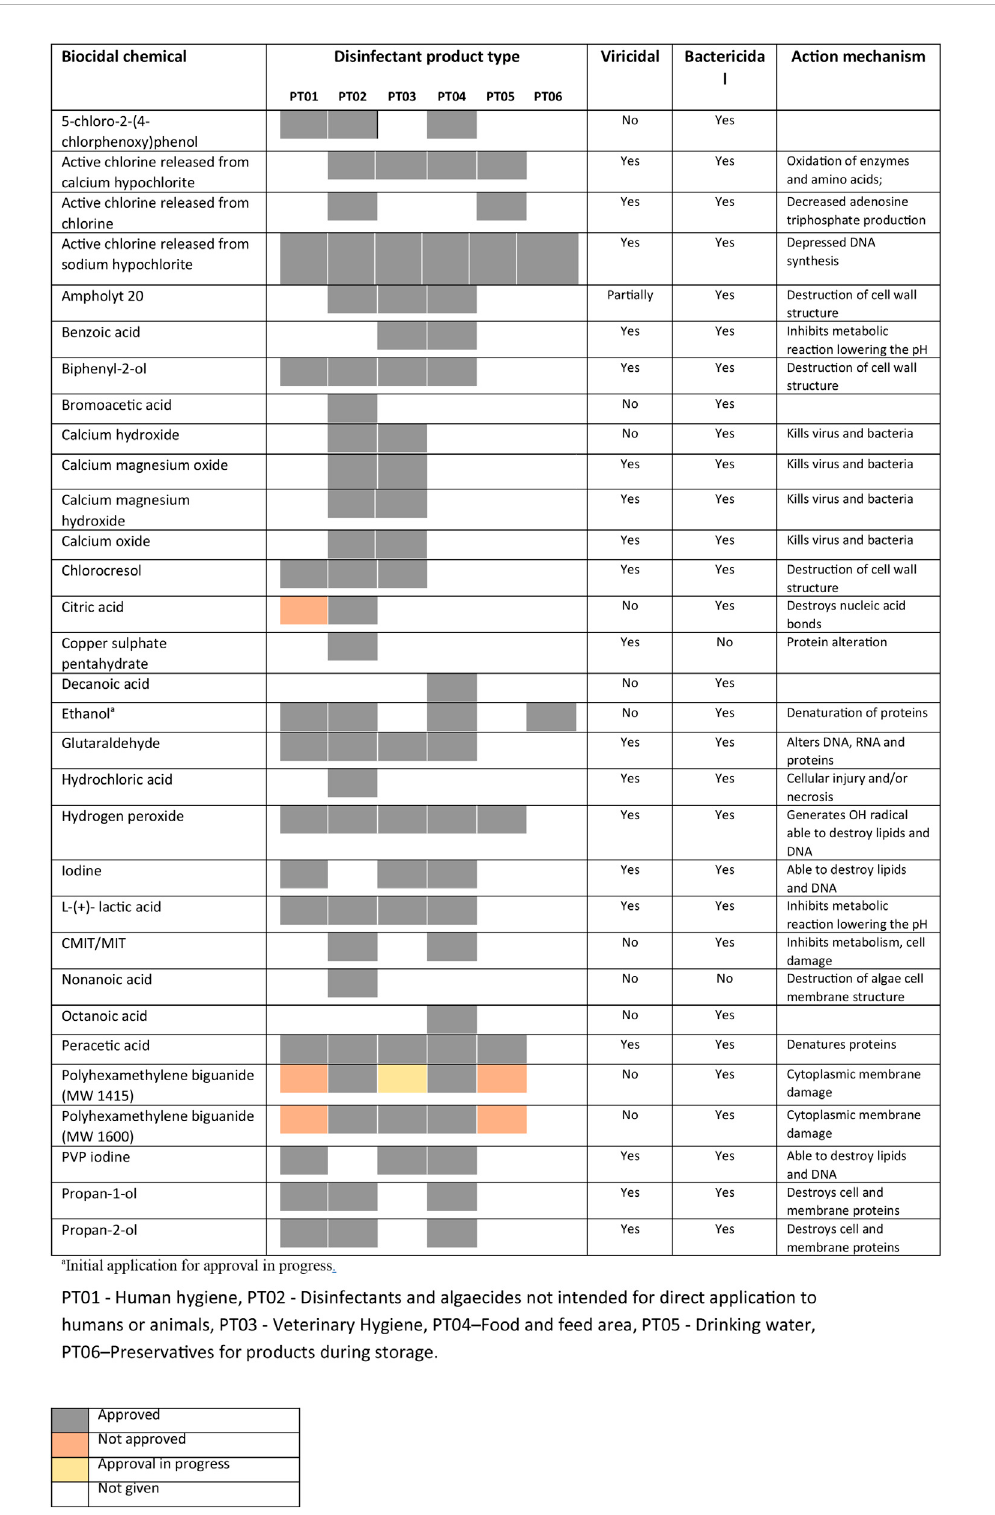
TABLE 1 | List of the principal European approved chemical biocides.